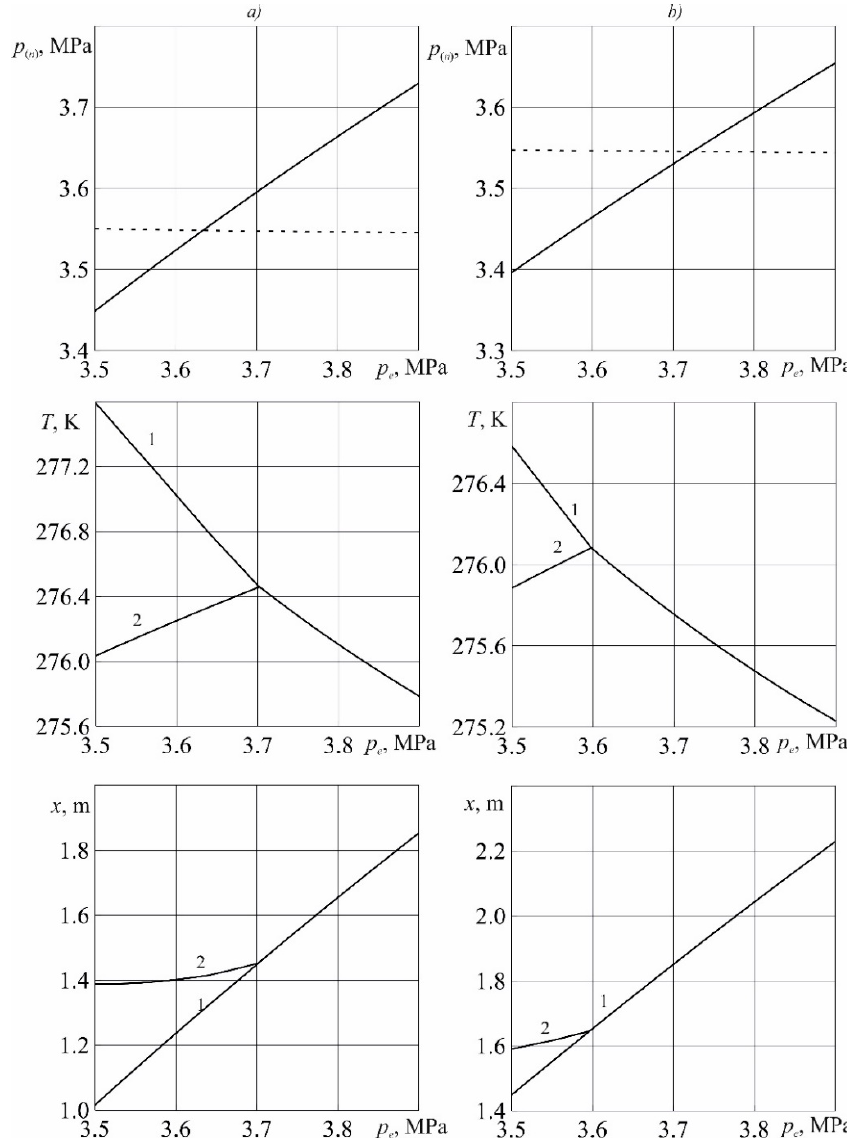
Figure 4. Dependencies of pressures, temperatures and coordinates of phase transitions on carbon dioxide injection pressure. p 0 = 3.1 MPa ( a ) and 2.9 MPa ( b ).